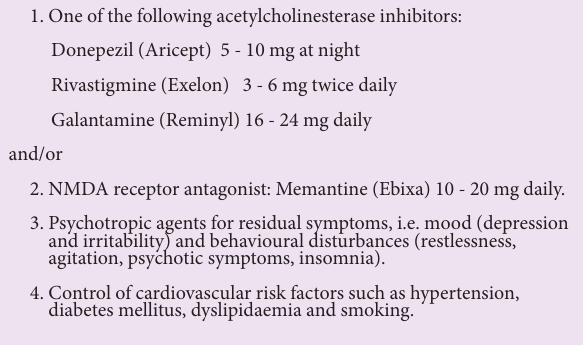
Table 2. Pharmacological treatment schedule for Alzheimer’s disease